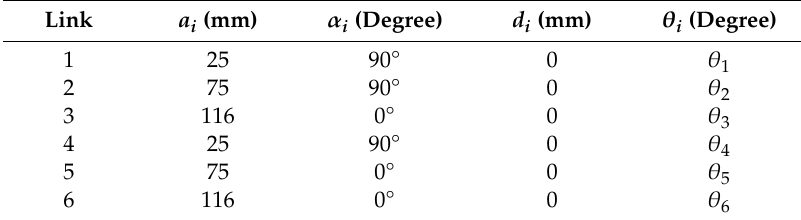
Table 1. Denavit–Hartenberg (DH) parameters on the extra robotic